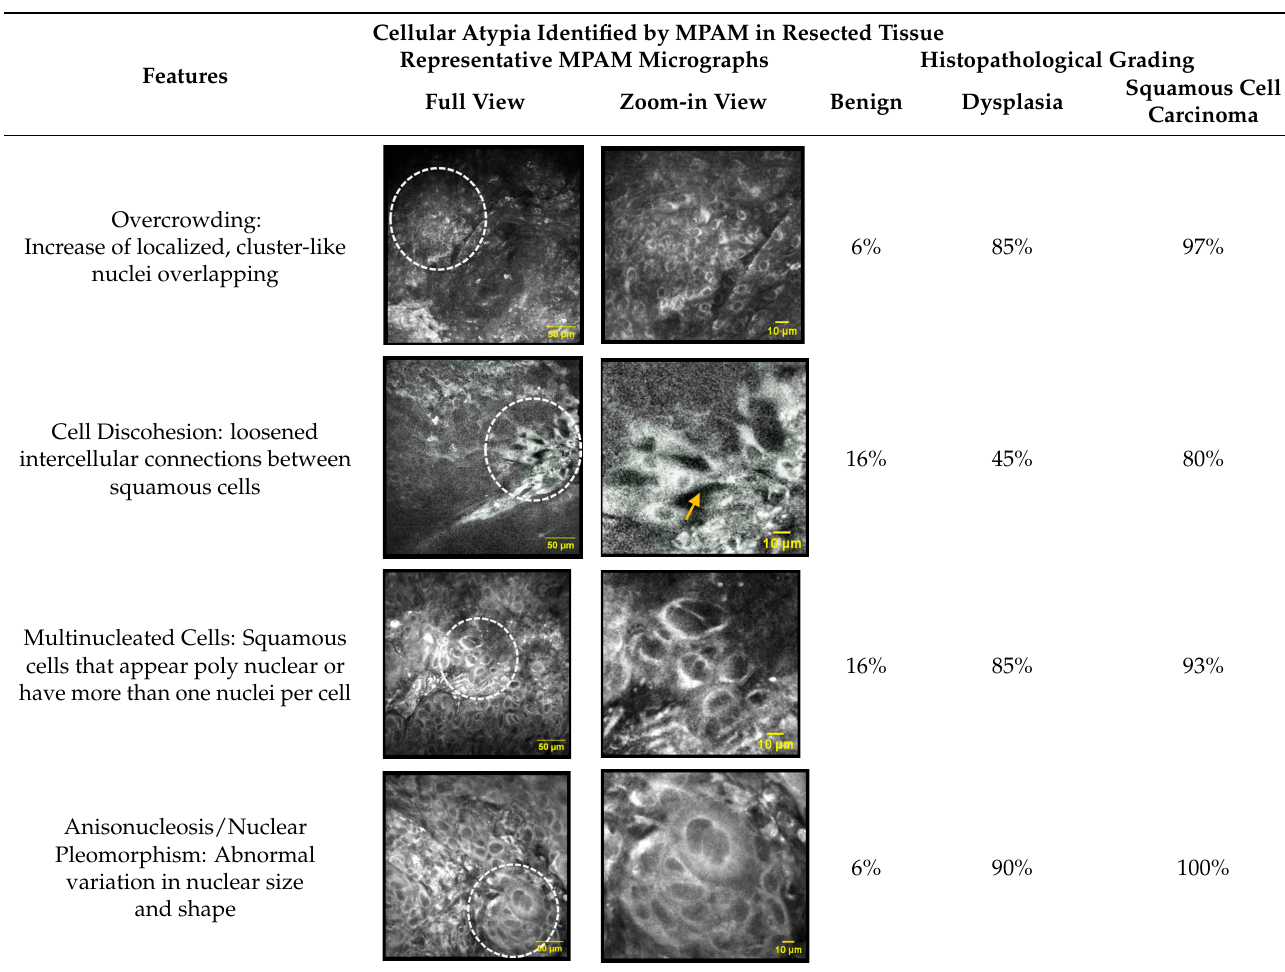
Table 1. Histopathological cellular features commonly used for histological grading can be visualized using MPAM. Representative whole and zoomed-in micrographs from tumors are shown next to feature criteria. Cellular discohesion is highlighted by yellow arrow. A tabulation of the percentage of all samples displaying the defined feature are shown for each histopathological grading (benign, dysplasia, and SCC) for all tumors imaged. Scale bar: 50 µm for full micrograph view; 10 µm for zoomed-in micrographs.